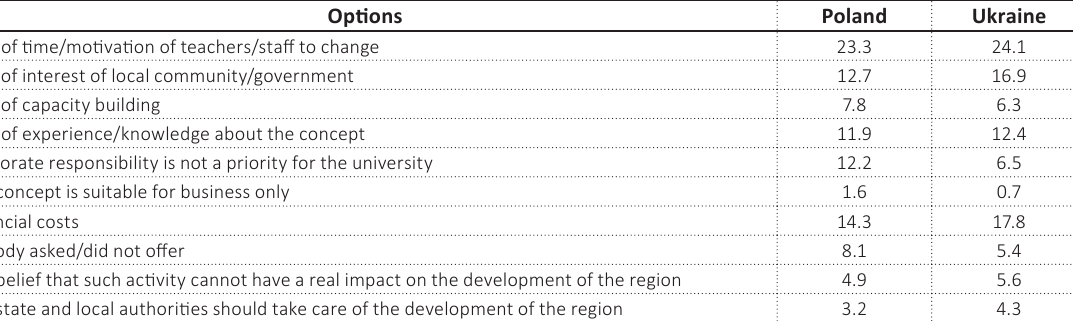
Table 8. Respondents’ answers to the question: What are the main obstacles to using the concept of corporate responsibility at your HEIs (multi-selection